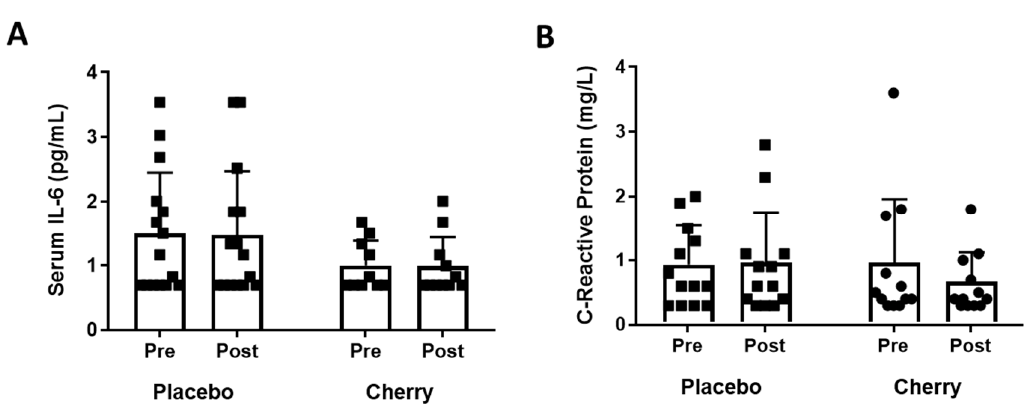
Figure 4. Systemic Inflammatory Burden in Placebo and Montmorency Cherry Supplemented Middle-Aged Participants. A total of 28 non-obese middle-aged men and women (40–60 years) consumed a daily dose of Montmorency cherry concentrate or an equivalent volume of glucose and energy-matched placebo for 4 weeks. IL-6 and CRP were quantified in plasma pre- and post-supplementation. ( A ) Serum IL-6 concentration; ( B ) Serum C-reactive protein concentration. Missing data points are due to values falling > 3 SD from the sample mean in participants reporting an acute illness. Black squares = placebo, black circles = cherry.